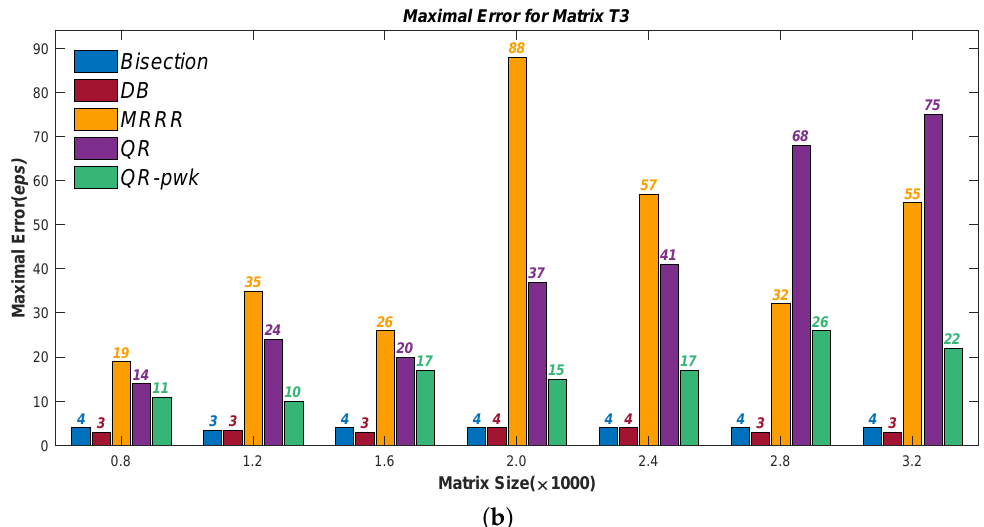
Figure 4. Results of Matrix T3: ( a ) the Average Errors; ( b ) the Maximal